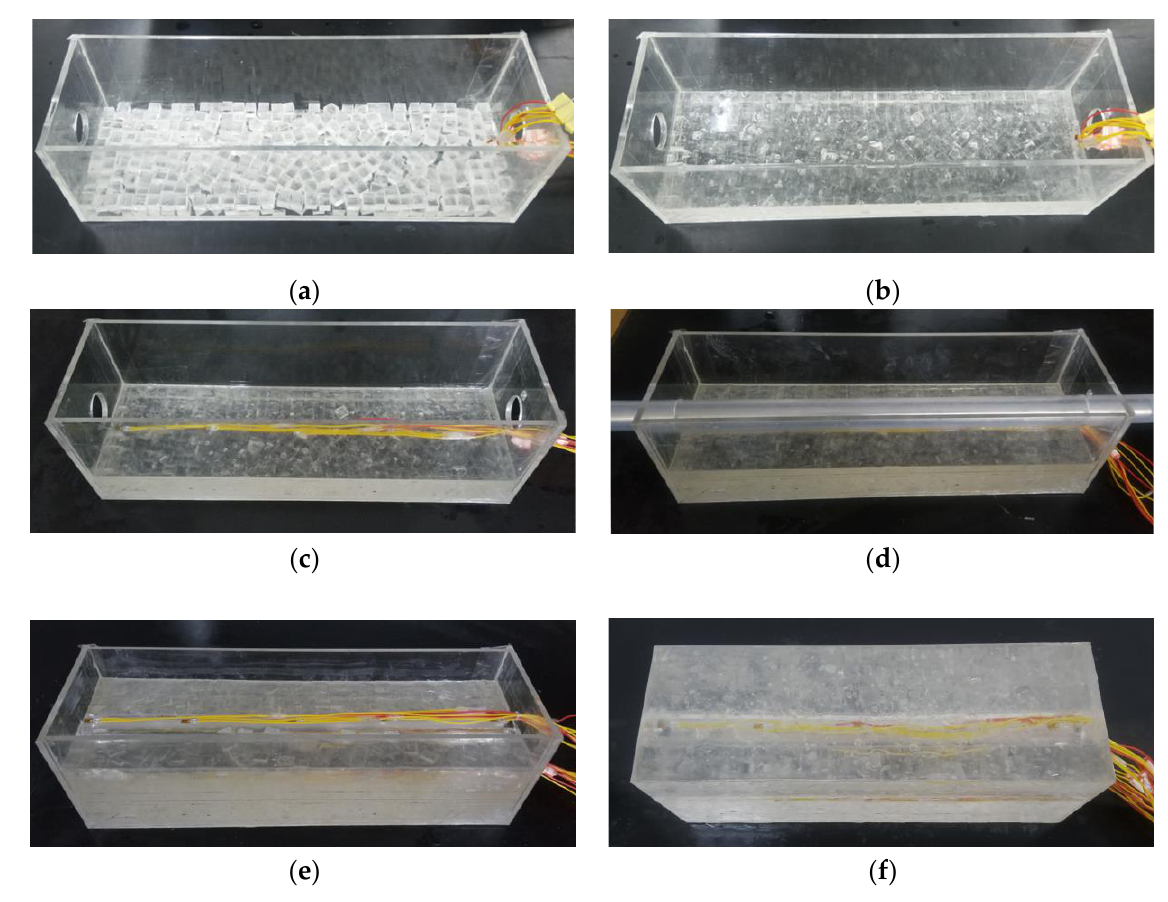
Figure 7. Transparent anchoring structure surrounding rock production process. ( a ) Putting transparent glue block ( b ) Casting transparent solution ( c ) Pasting the first layer strain gauge ( d ) Reserved holes ( e ) Pasting the second layer strain gauge ( f ) End of specimen production.